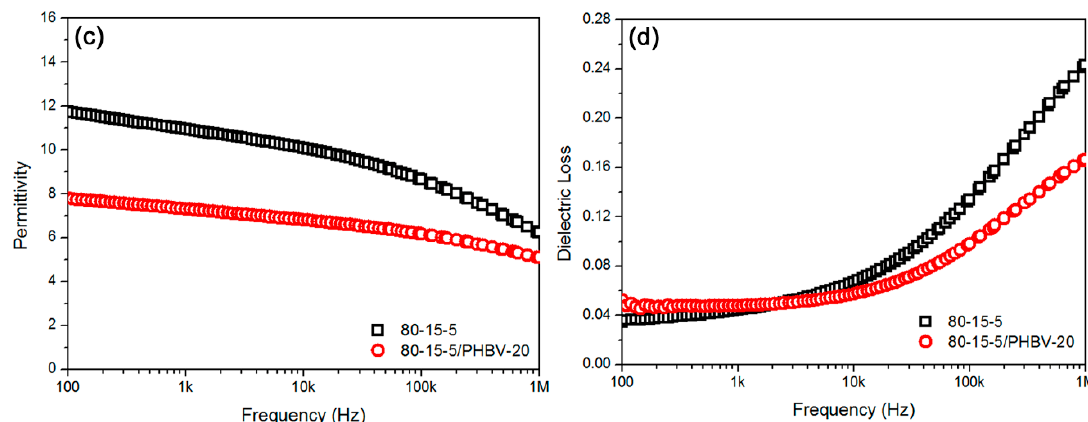
Figure 1. ( a ) Schemed diagrams showed the molecular structures of four main original materials, ( b ) 1 H NMR results confirmed the chemical compositions of the four materials; ( c ) Permittivity results showed a reduction of the permittivity for composite sample in comparison to neat 80-15-5 sample, ascribed to a reduction of the size of ferroelectric domains in 80-15-5 component from dilution effect of PHBV component; and ( d ) loss results showed a decrease of loss for composite at high frequency, compared with neat 80-15-5, ascribed to low dielectric response in PHBV component as well as reduction of inner friction during dipoles reversal in 80-15-5 component.